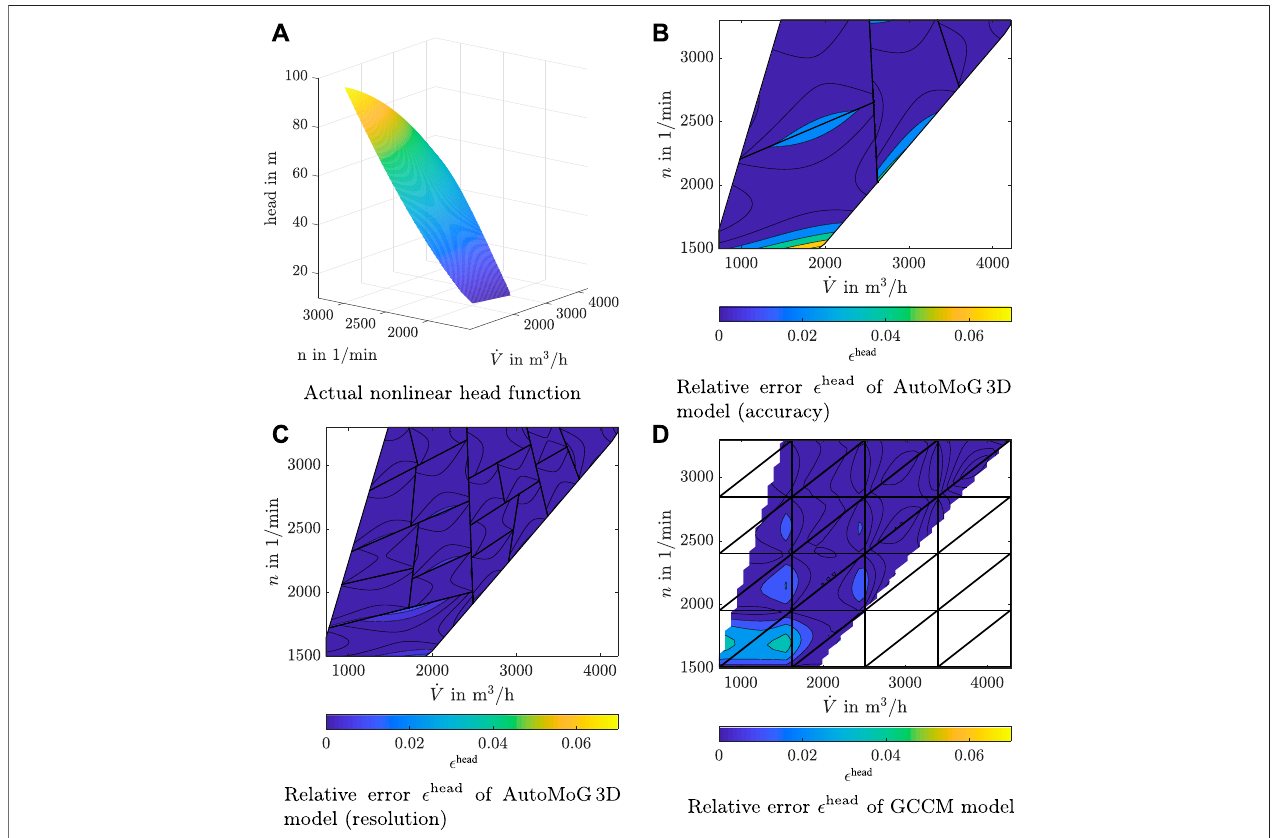
FIGURE8| Actualnonlinearheadfunctionofavariable-speedpump (A) ,andtherelativeerrorsoftheAutoMoG3Dmodelwithsameaccuracy (B) andcomparable resolution (C) compared to the relative error of the generalized-convex-combination method (GCCM) model (D) for the head function of a variable-speed pump.